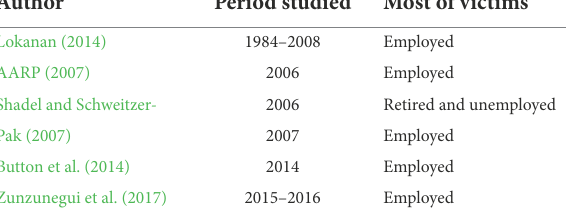
TABLE 5 Profiles of victims according to professional status across